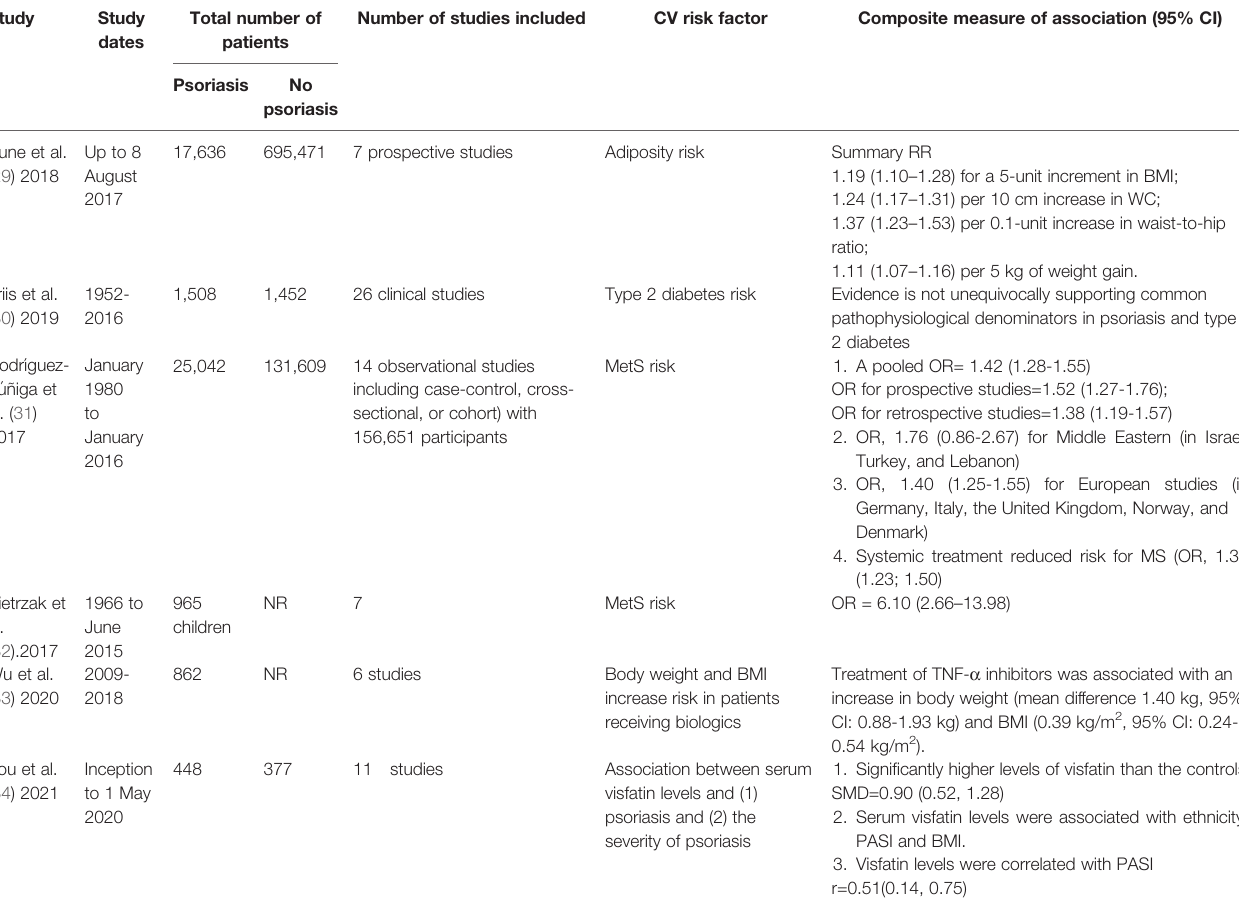
TABLE 2 | Summary of systematic review and meta-analyses assessing the association between psoriasis and metabolic diseases-cardiovascular disease risk